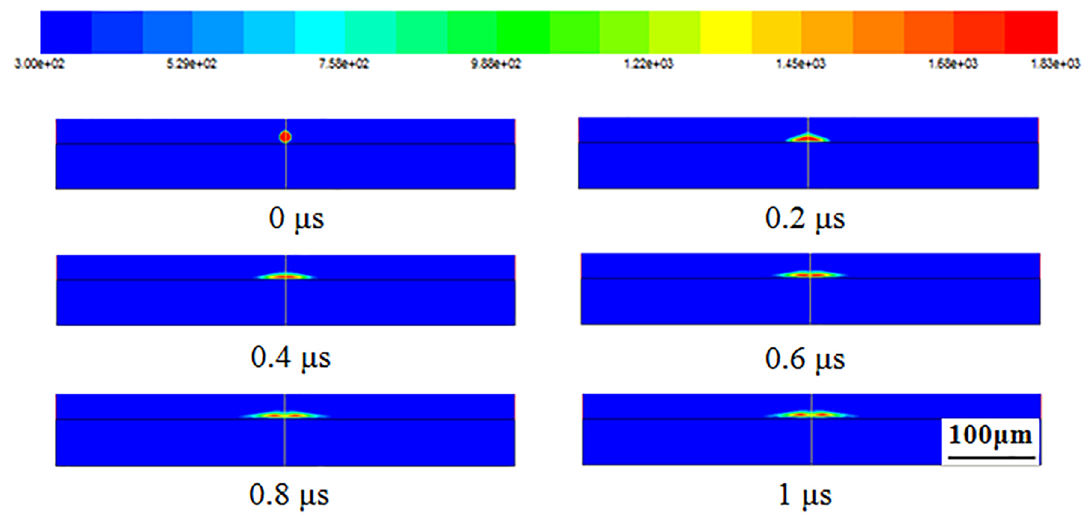
Figure 6. Change of solidification temperature field of TWAS droplet (ø25 μm, 100 m/s).